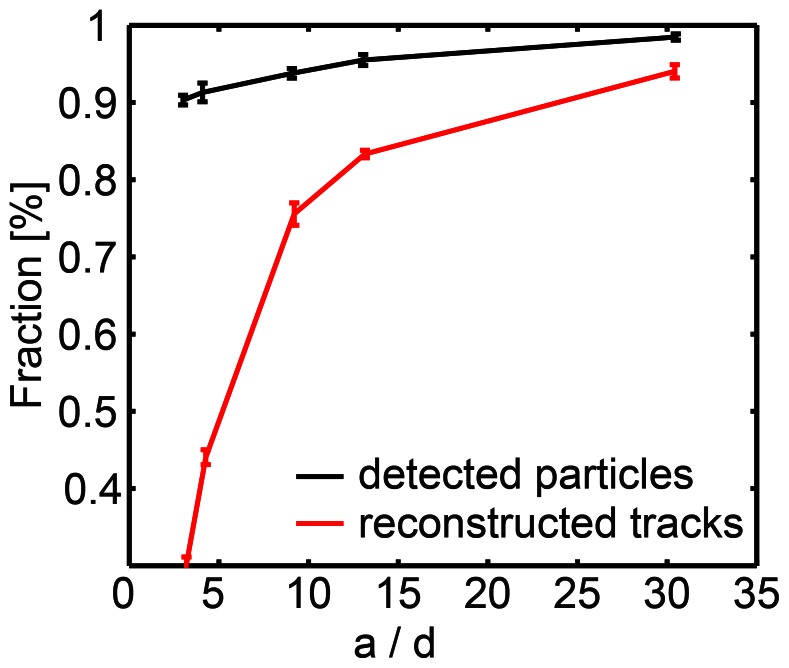
Validation of tracking function on simulated data.The fraction of detected particles and fully reconstructed tracks (number of true positives/ground truth (GT)) as a function of the ratio of the average nearest neighbor distance over the average displacement a/d. Image stacks with 150 particles were simulated over 30 frames. In the first image frame particles were located at a distance 5×radius of Airy disk from each other and then moved assuming Brownian motion in subsequent frames. d was varied. Each data point shows the mean value of 50 repetitions.